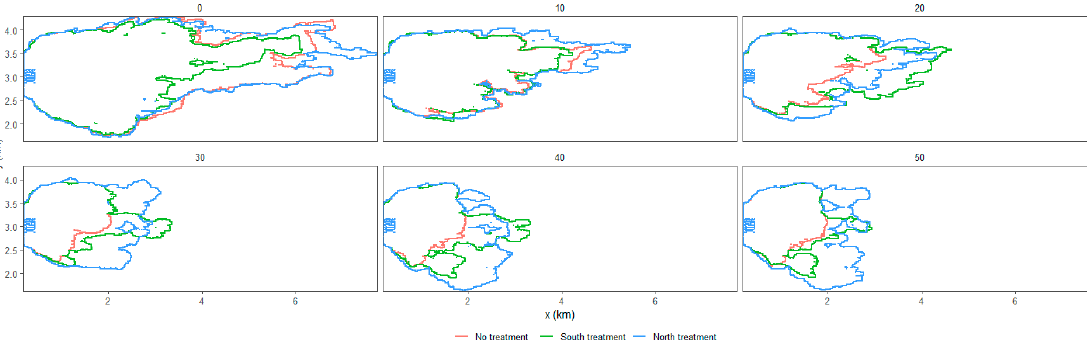
Figure 6. Mean percentage of fire area burned as active crown fire, passive crown fire and surface fire across all scenarios at each time step in the simulation, broken out by aspect and treatment status. 3.2. Effects of Treatments over Time In untreated stands in all three of the scenarios, CBH increased from approximately 2–3 m over the first 30 years of the simulations, at which time CBH stabilized over the remaining 20 years (Figure